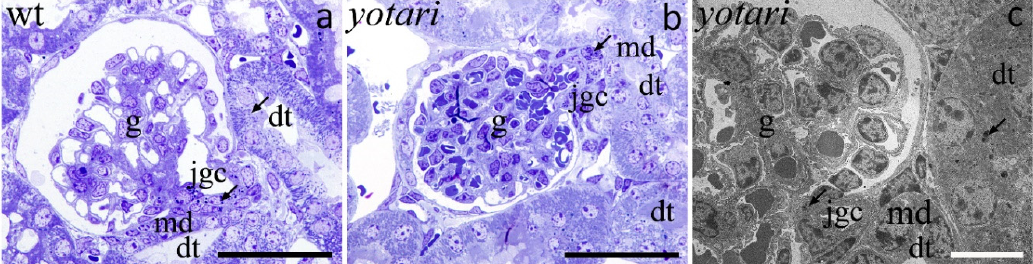
Figure 8. Light microscopy (LM) and transmission electron microscopy (TEM) images of wild type and yotari kidneys on P14. Semi-thin sections of the kidneys of wild type animals with typical histological structure ( a ). Semi-thin sections of the kidneys of yotari animals with juxtaglomerular apparatus and renin granules in different kidney structures (arrows) ( b ). Representative electron microscope photograph of glomeruli with juxtaglomerular apparatus ( c ). Renin granules (arrows), glomeruli (g), macula densa (md), juxtaglomerular apparatus (jgc), and distal convoluted tubules (dt). Scale bars are 50 μ m ( a , b ) and 10 μ m ( c ).